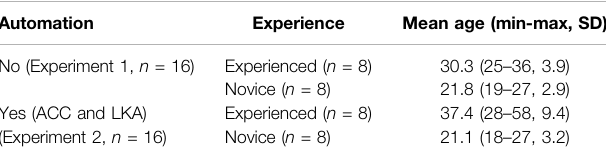
TABLE 1 | Age information for the participants whose data were used in the current analyses, i.e., for participants who completed the secondary task condition. Automation and experience are both between-subjects variables; SD: standard